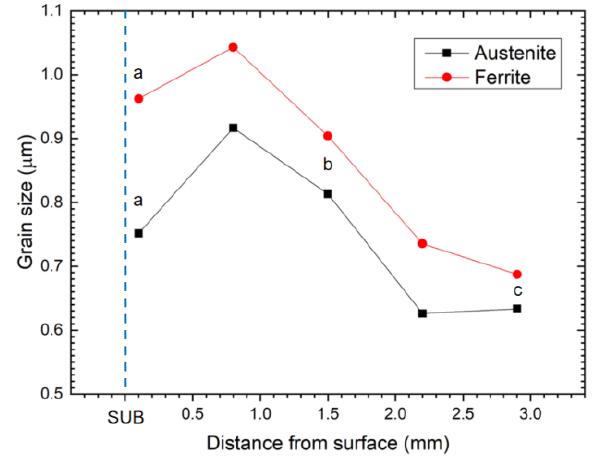
Figure 12. Grain size profiles of austenite and ferrite phases along the centerline. Regions a, b, and c are 0.1, 1.5, and 2.9 mm beneath the surface, respectively.